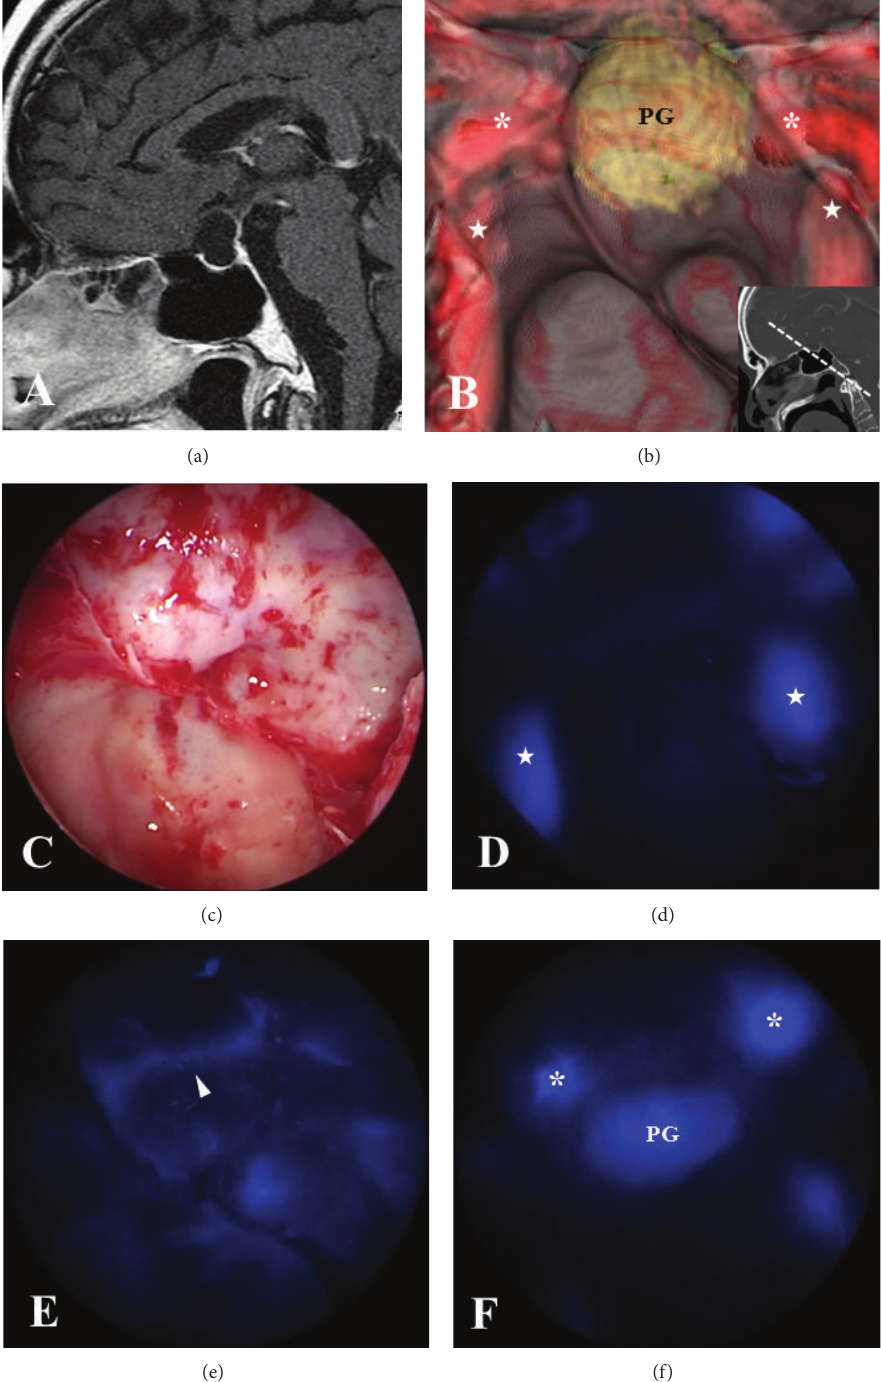
Figure 3: Preoperative image of a fusion model of 3D-CT and MRI and intraoperative endoscopic view along with ICG endoscopic views at each elapsed time in Case 2 . (a) Preoperative sagittal Gd-enhanced MRI in Case 2 showing a cystic lesion in the sellar and suprasellar region. (b) A fusion model of 3D-CT and MRI demonstrating an anatomical relationship between bilateral ICAs and the pituitary gland that is flattened at the sellar floor. The bony structures are partially eliminated (asterisks: C3; stars: C4) and the normal pituitary gland (PG). (c) Endoscopic view demonstrating the structures around the sella that correspond to the fusion model. (d, e, f) ICG endoscopic views visualizing bilateral ICAs in the carotid prominences (stars) at the earliest phase, followed by ICS (arrowheads), and the normal pituitary gland (PG) at 5 to 10s